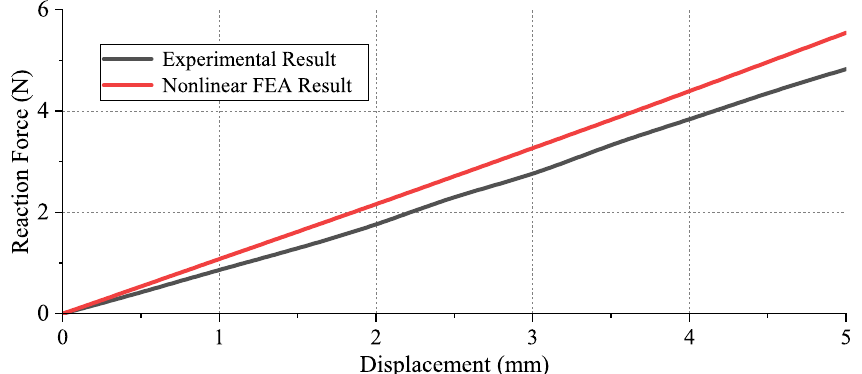
Figure 11. The comparison between the experimental results and nonlinear FEA